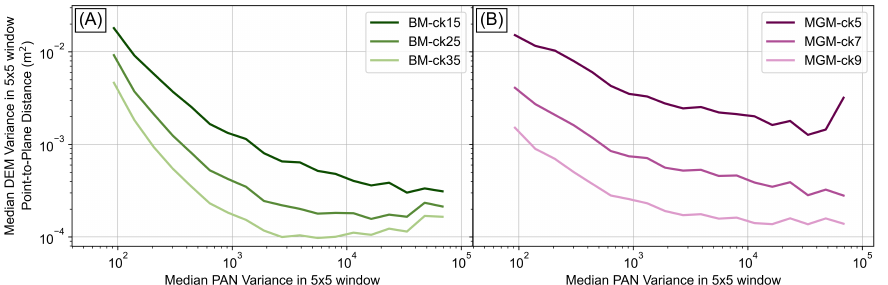
Figure 8. Median binned line generated in Figure 7D for BM-ck25, here shown for ( A ) all BM DEMs and ( B ) all MGM DEMs (cf. Table 1). The BM algorithm has a more steeply dipping relationship, but both BM and MGM have a plateauing behavior above ∼ 10 3 PAN variance. Larger CK sizes preserve the shape of the relationship but result in lower DEM variance for the same PAN